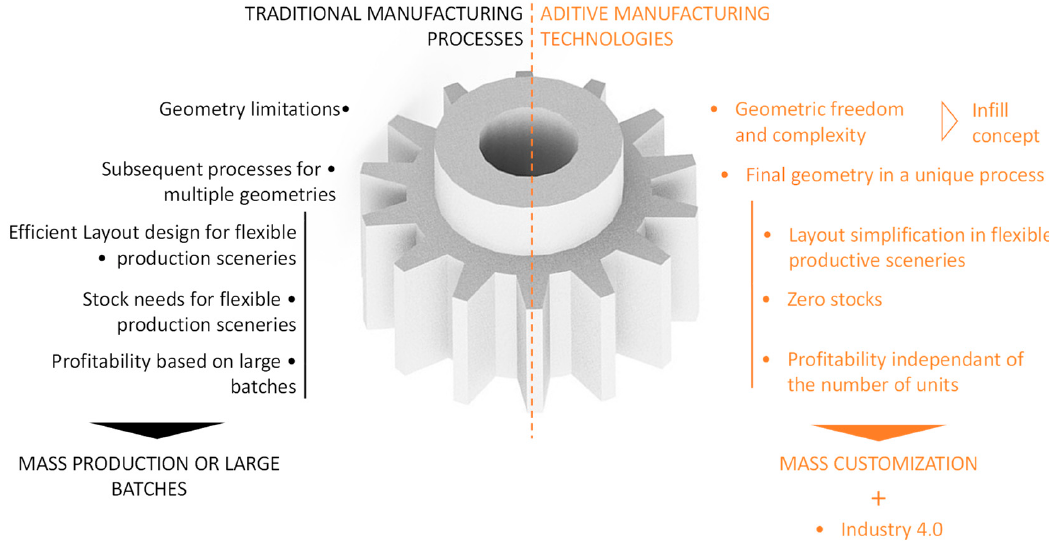
Figure 1. Main differences of additive manufacturing technologies compared to traditional manufacturing